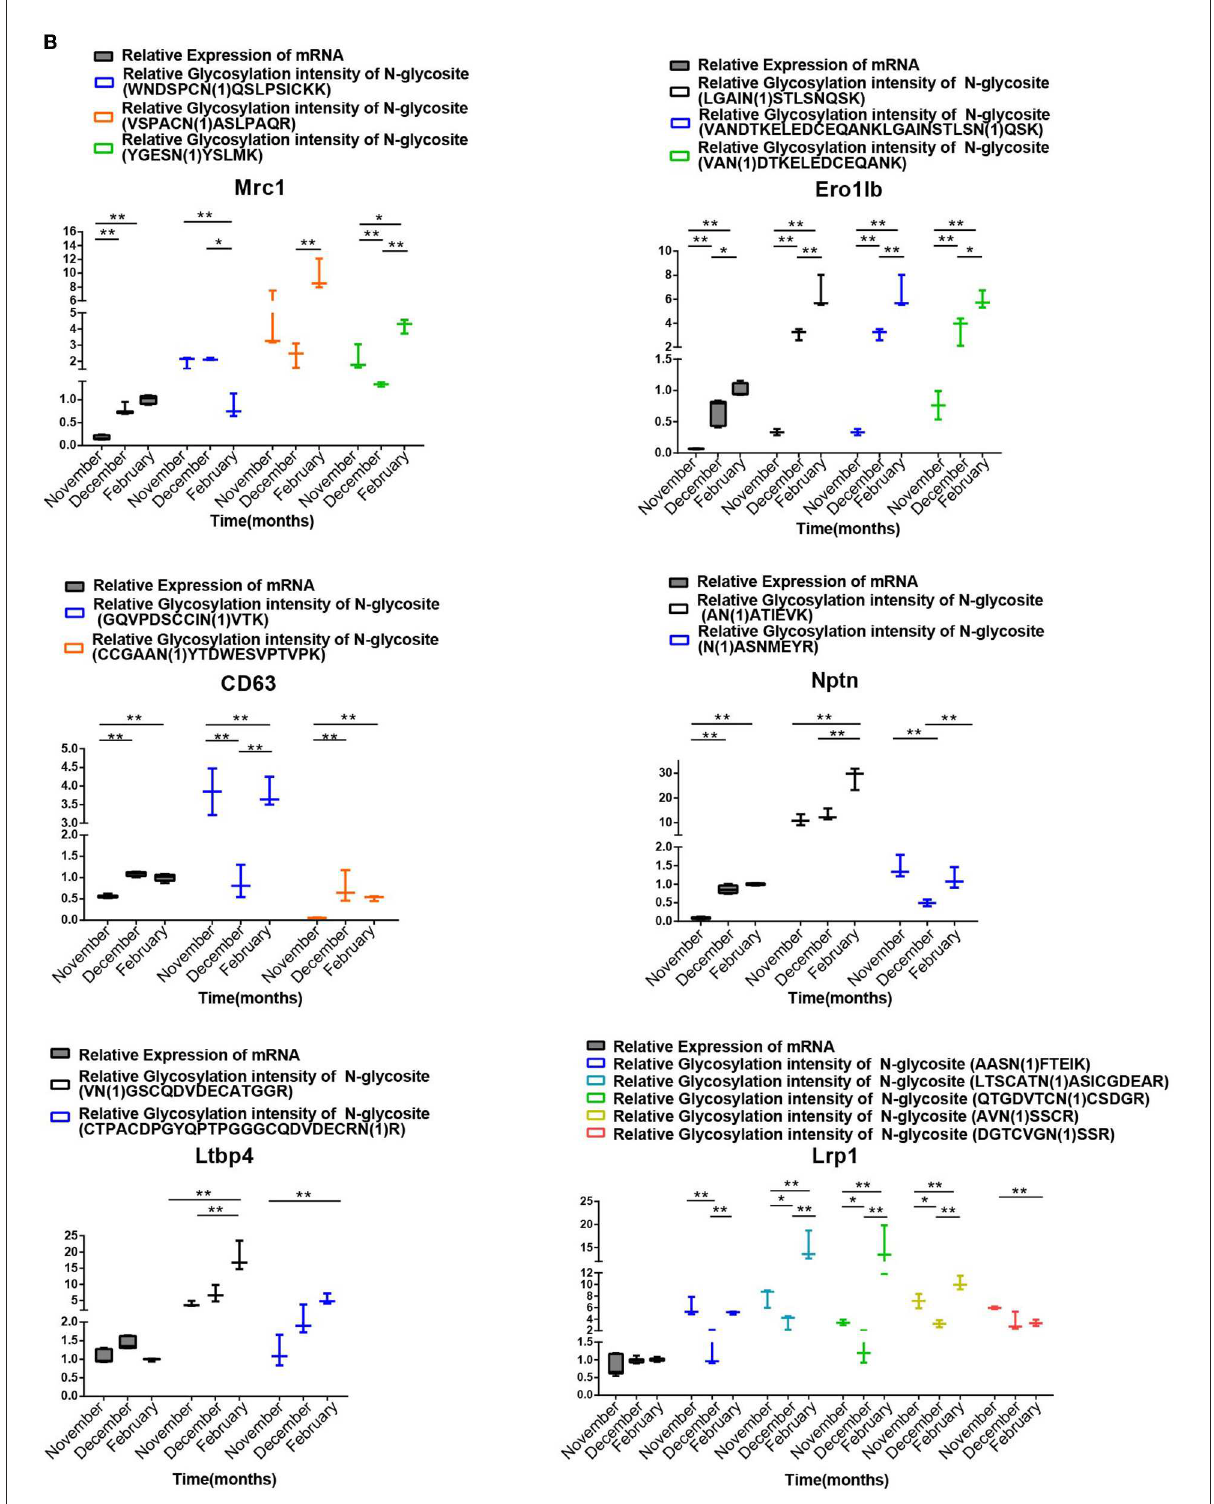
FIGURE8B Analysis of the relationship between the transcript levels of different N-glycosylated testis protein genes in different stages of spermatogenesis and their relative ionic intensity of different N-glycosylated peptides contained in the corresponding proteins. One-way ANOVA with Tukey post hoc test was used for data statistics. Data are presented as mean with 95% CI. P < 0.05 was considered significant. * p < 0.05, ** p <